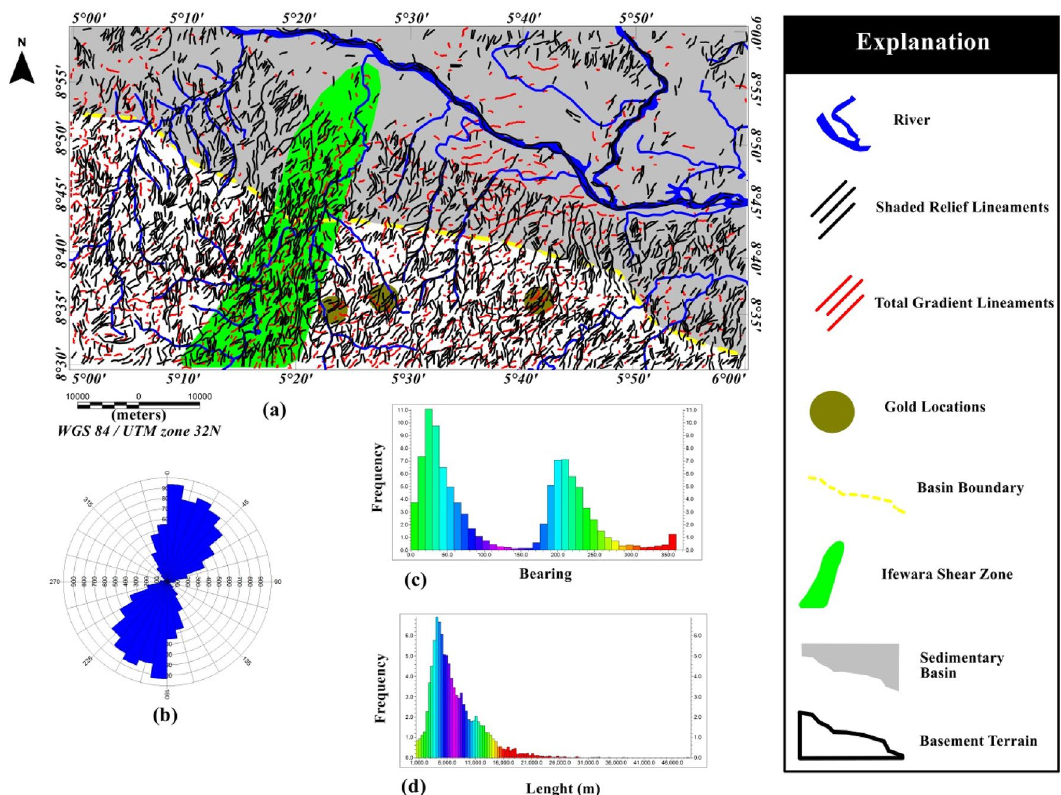
Figure 8. ( a ) Composite structural map of southern border of the Middle Niger Basin produced from the combined analysis and interpretation of SRTM and high resolution aeromagnetic anomaly data. The map depicts good information about surface and subsurface lineament distribution within the study area. Surface lineaments were produced from the multi-illumination shaded-relief map of the southern border of the Middle Niger Basin using a 45 degrees light angle at azimuths 225, 270, 315, and 360 degrees. ( b ) Rose-diagram computed from the automatic extracted surface lineaments, showing that the lineaments are mainly